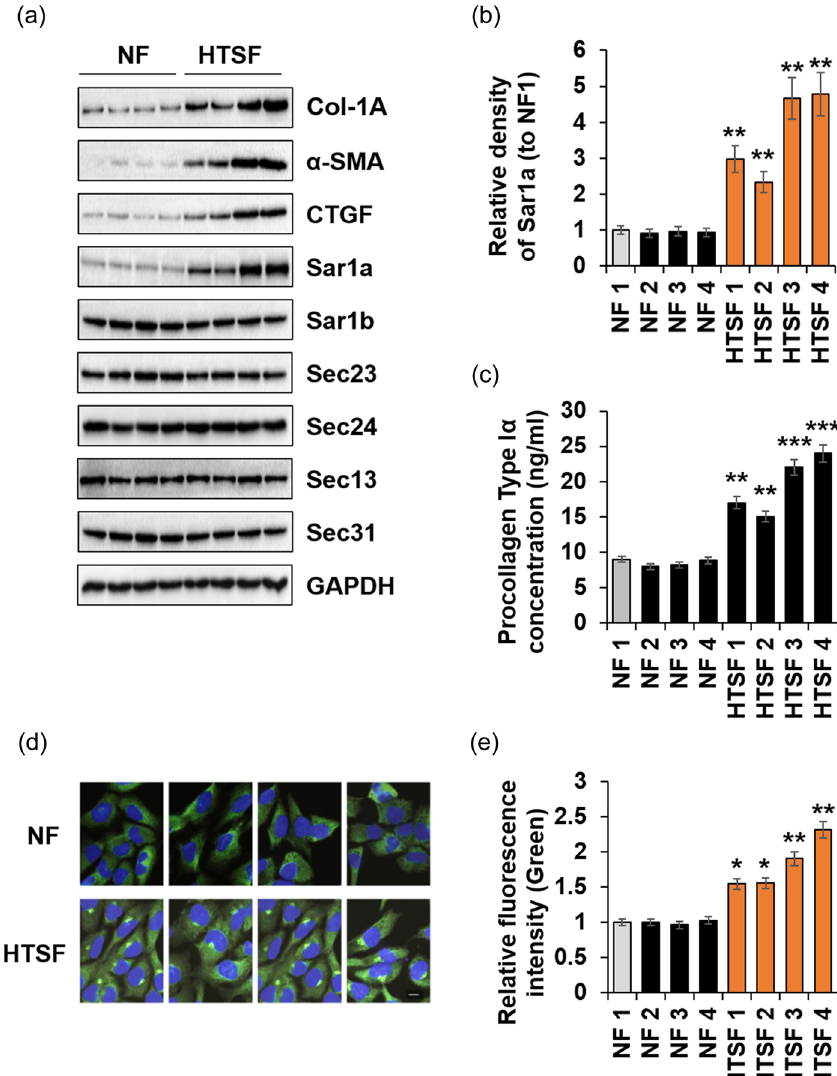
Figure 1: Di ff erential expression of Sar1a between NF and HTSF. Isolated NFs or HTSFs were cultured in 6 - well plates. The cell culture supernatant was collected for PC - I ELISA ( c ) , and cell lysates were immunoblotted with antibodies against the indicated proteins ( a ) . ( a ) Immunoblots of Col - 1A, α - SMA, CTGF, Sar1a, Sar1b, Sec23, Sec24, Sec13, Sec31, Sec12p, and the loading control GAPDH. ( b ) Fold change of Sar1a was calculated ( n = 3, ± SD ) ; ** p < 0.01 vs NF 1. ( c ) NF or HTSF were cultured until near con fl uence, and they were then starved in serum - free DMEM for 24 h. Secreted PC - I was determined via ELISA ( n = 3, ± SD ) ; ** p < 0.01 and *** p < 0.001 vs NF 1. ( d ) Cultured cells were stained with anti - Sar1a ( FITC, green ) and DAPI ( blue ) , and images were obtained using a fl uorescence microscope ( Scale bar: 10 μ m ) . ( e ) Images were captured, and the fl uorescence intensity was quantitated using ImageJ software ( n = 3, ± SD ) ; * p < 0.05 and ** p < 0.01 vs NF